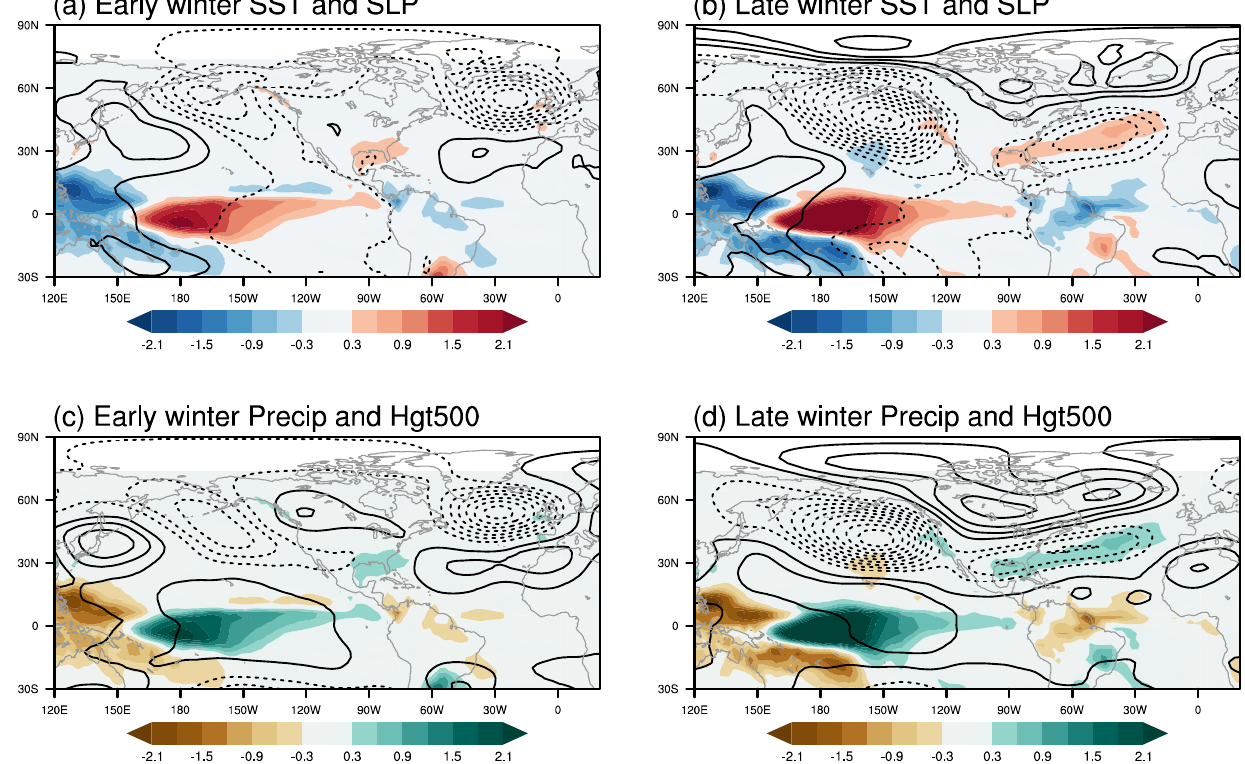
Figure 4. Anomalous SST (shading: ◦ C) and SLP (contour: hPa) anomalies in ( a ) early winter and ( b ) late winter regressed upon the standardized simultaneous Niño3.4 index. Anomalous precipitation (Precip for short; shading, mm/day) and geopotential height at 500 hPa (Hgt500 for short; contour, m) in ( c ) early winter and ( d ) late winter regressed upon the standardized simultaneous Niño3.4 index. Solid lines indicate the positive values and dashed lines indicate the negative values of SLP in ( a , b ) and Hgt500 in ( c , d ). The contour interval is 0.3 hPa in ( a , b ) and 0.3 m in ( c , d ). Accompanied by the enhancement in the tropical Pacific precipitation anomalies, the atmospheric anomalies of the Aleutian Low are evidently enhanced in late winter (Figure 4b,d). Correspondingly, the two downstream centers of the PNA teleconnection pattern are clearly established over North America. These two downstream centers extend from North America to the central North Atlantic ocean with a southwest-to-northeast tilt, resembling the negative NAO pattern. In contrast, the atmospheric response in the Aleutian Low is weak, and the PNA teleconnection pattern is not fully established in the early winter of ENSO years (Figure 4a,c). In early winter, a prominent atmospheric response can